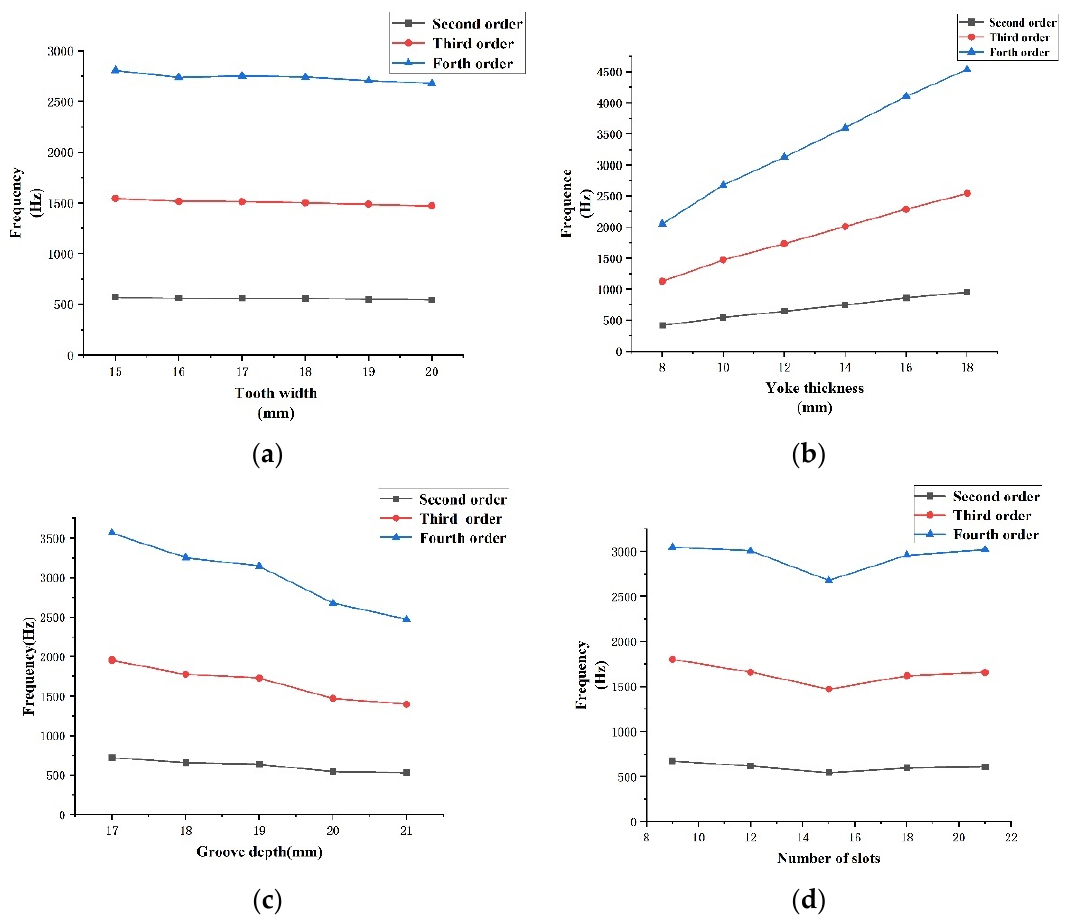
Figure 11. Frequency variation in stator modes with different parameters: ( a ) tooth width; ( b ) yoke thickness; ( c ) number of slots; and ( d ) slot depth.